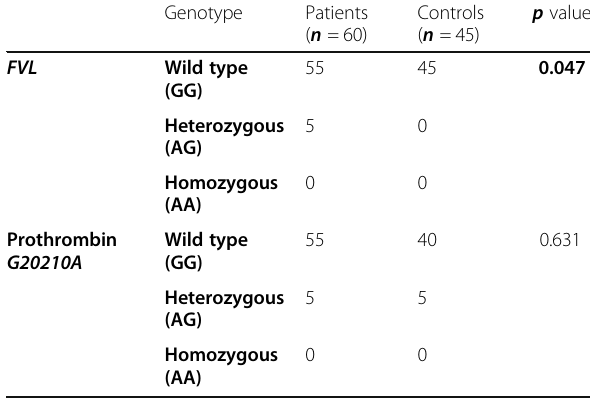
Table 5 Distribution of FVL and prothrombin G20210A mutations in women with RPL and control women